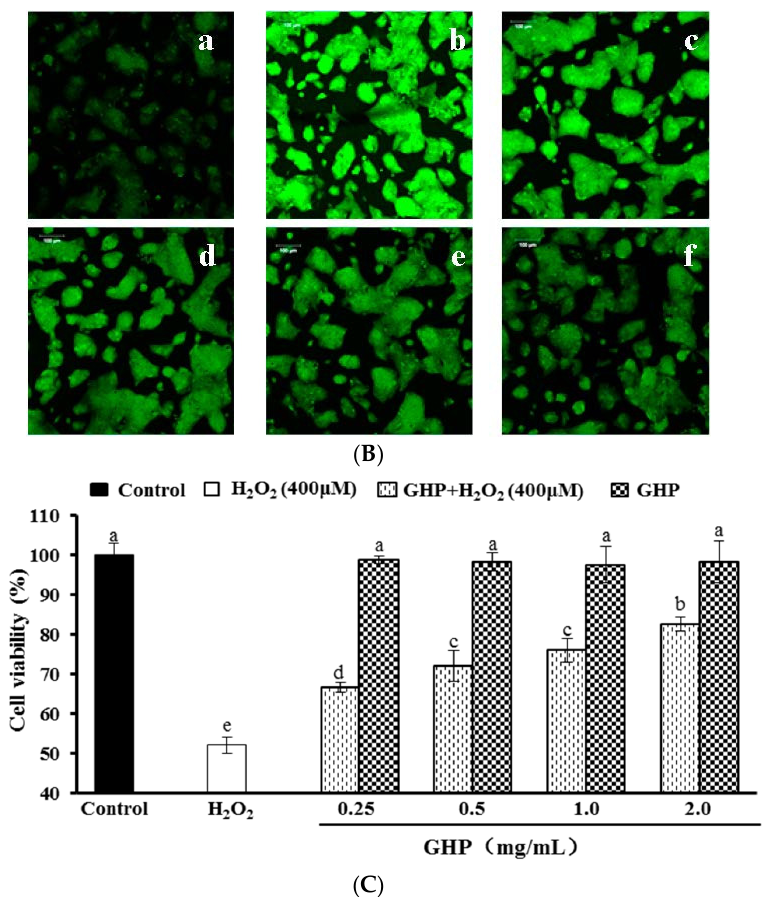
Figure 2. Protective effects of GHP (glycomacropeptide hydrolysates) against H 2 O 2 ‐ induced oxidative stress. ( A ) Cells pretreated with indicated concentrations of GHP for 12 h were stimulated with 400 μ M H 2 O 2 for 30 min. ROS (reactive oxygen species) levels were measured by DCF ‐ DA with fluorescent analysis; ( B ) The ROS levels were analyzed using a confocal scanning system. ( a ) Cells were treated with normal culture medium, ( b ) Cells were treated with 400 μ M H 2 O 2 , ( c – f ) Cells were pretreated with 0.25, 0.5, 1.0, 2.0 mg/mL GHP, respectively, before 400 μ M H 2 O 2 treatment; ( C ) Cells